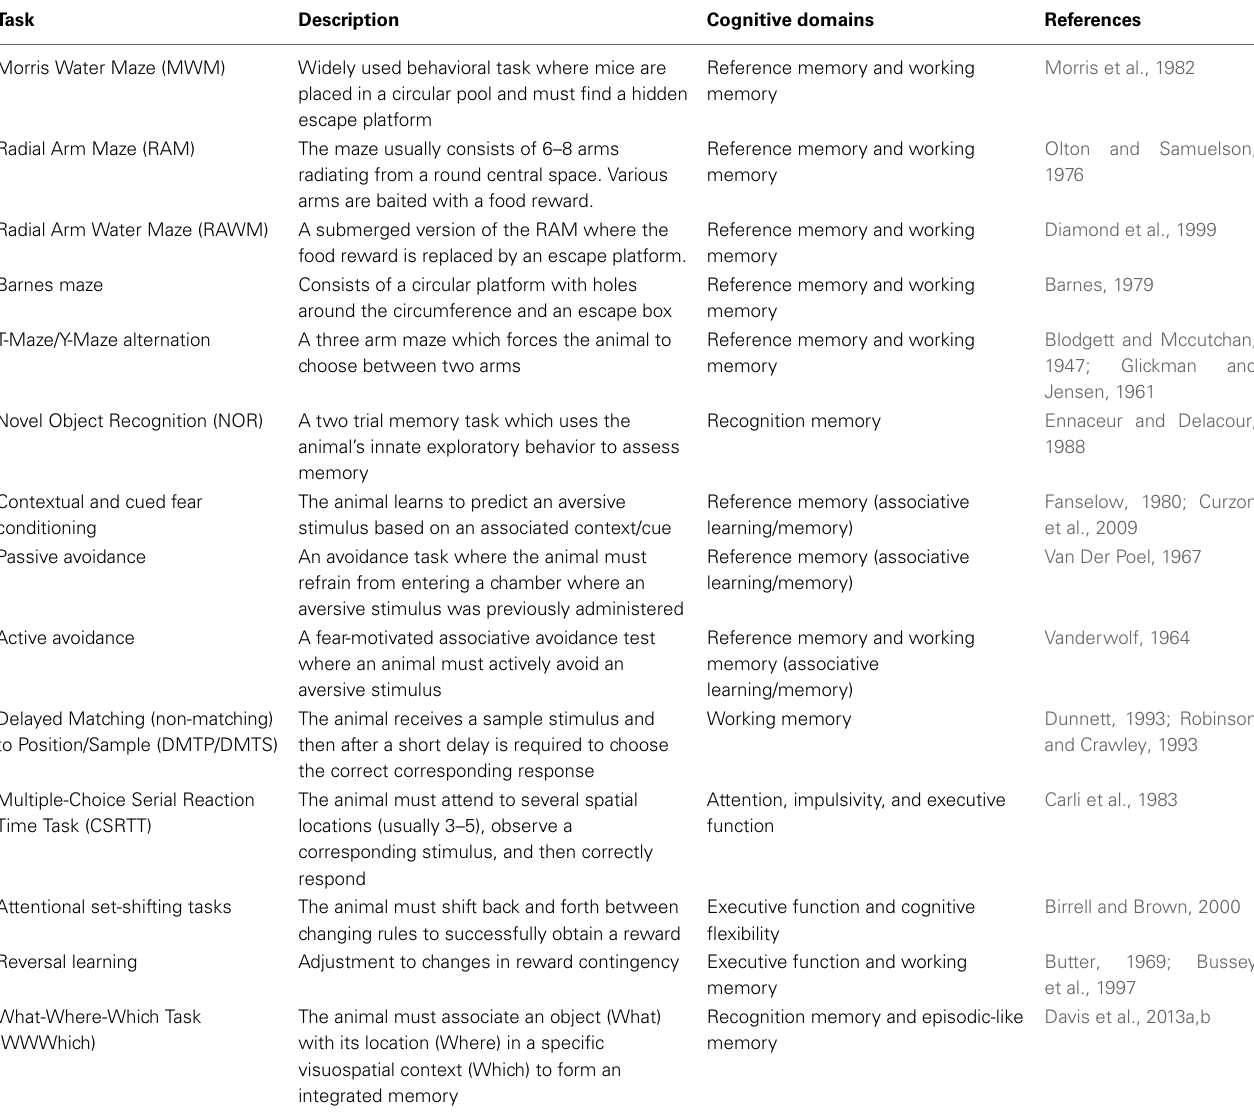
Table 2 | Commonly used mouse behavioral